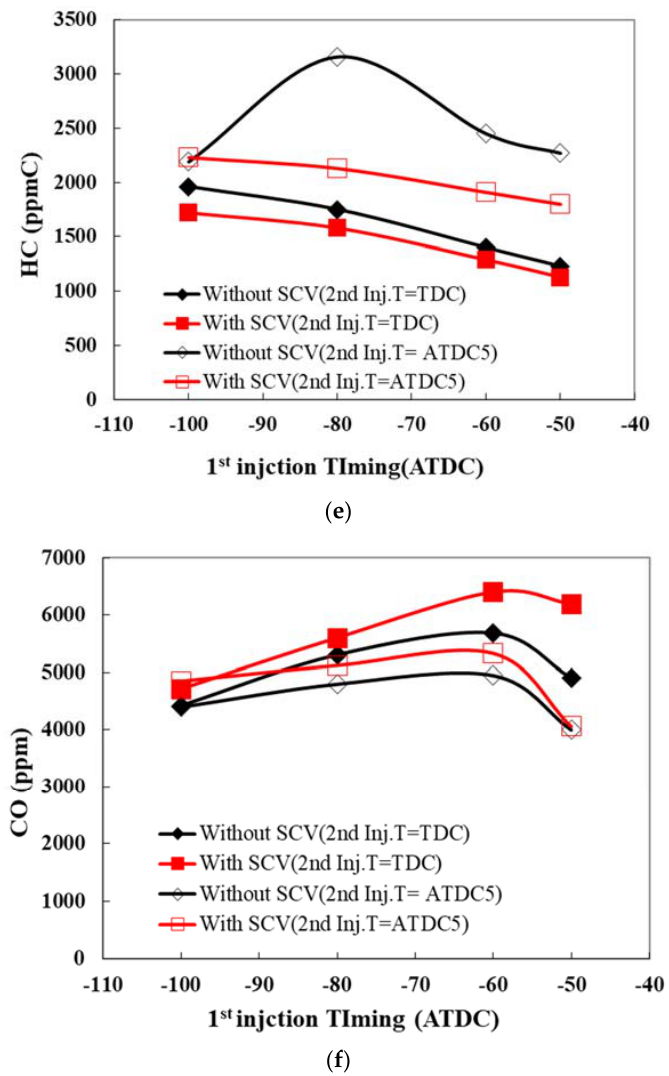
Figure 7. IMEP and emission performance applied SCV at the multi-injection mode (20 mm 3 /stroke, 1400 rpm). ( a ) IMEP; ( b ) A/F; ( c ) NO x ; ( d ) Smoke (FSN: Filter Smoke Number defined according ISO 10054); ( e ) HC; ( f ) CO.